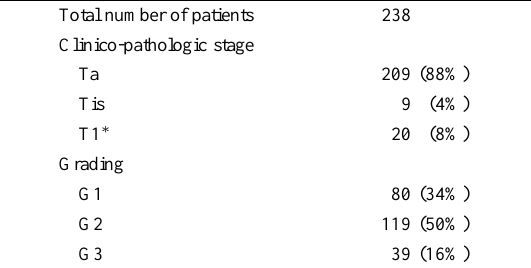
Clinico-pathologic characteristics of the study population Total number of patients